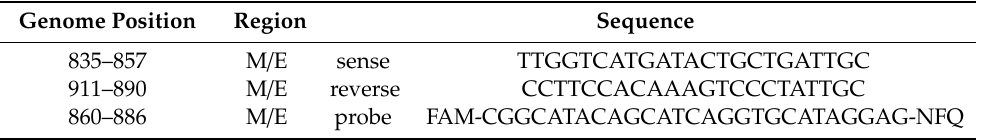
Table 1. Oligonucleotide sets to amplify ZIKV